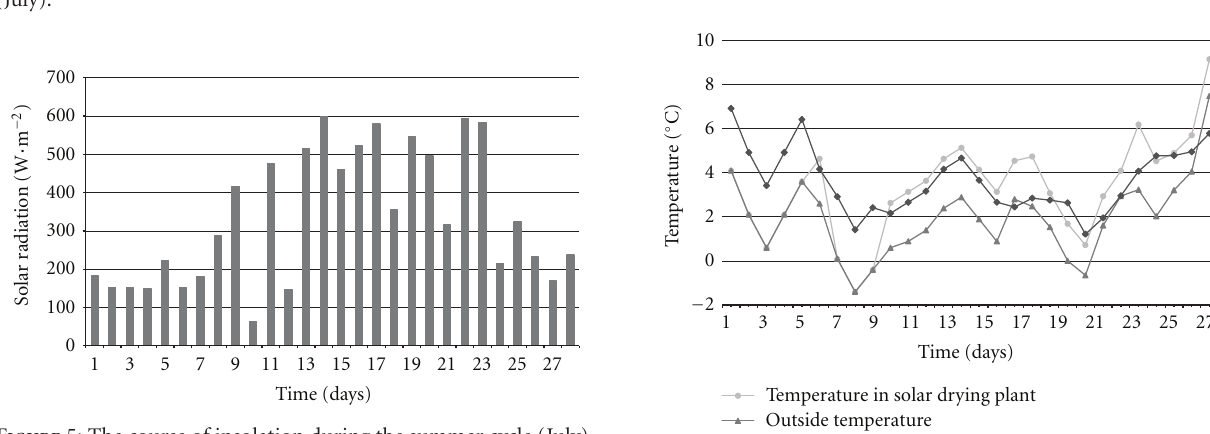
Figure 4: The course of temperature during the summer cycle (July).